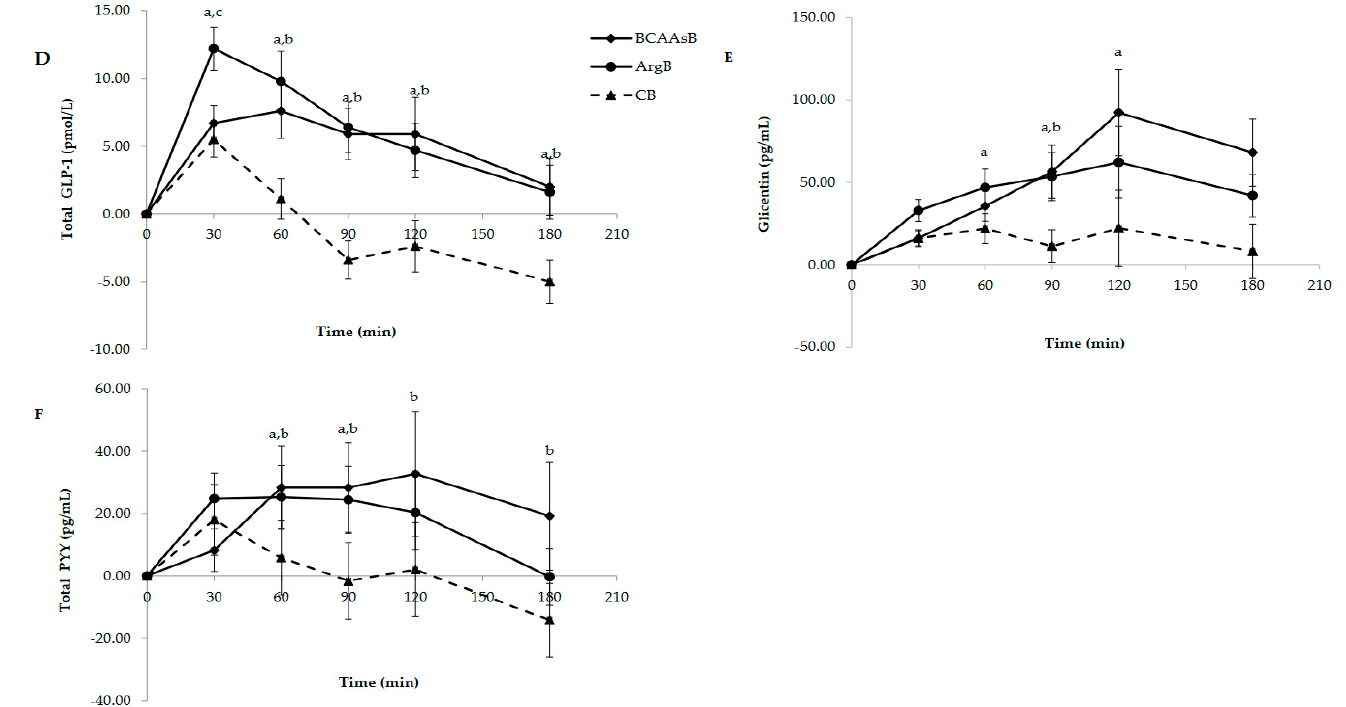
Figure 1. Responses of glucose ( A ), insulin ( B ), ghrelin ( C ), GLP-1 ( D ), glicentin ( E ) and PYY ( F ) of subjects, 3 h after the consumption of the three tested biscuits. Values are expressed as mean ± SEM ( n = 30). a p < 0.05 between ArgB and CB, b p < 0.05 between BCAAsB and CB, c p < 0.05 between BCAAsB and ArgB, d p < 0.05 between GS and ArgB, BCAAsB, CB, e p < 0.05 between GS and BCAAsB, ArgB. Table 3. Incremental areas under the curve (iAUC) for glucose, insulin, gastrointestinal hormone responses and subjective appetite ratings (hunger, fullness and desire to eat) after ingestion of the three